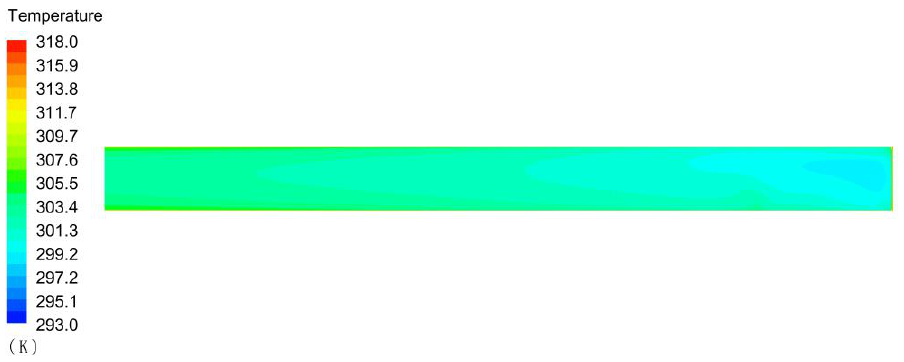
Figure 17. Model 5 roadway temperature side view (x = 0).